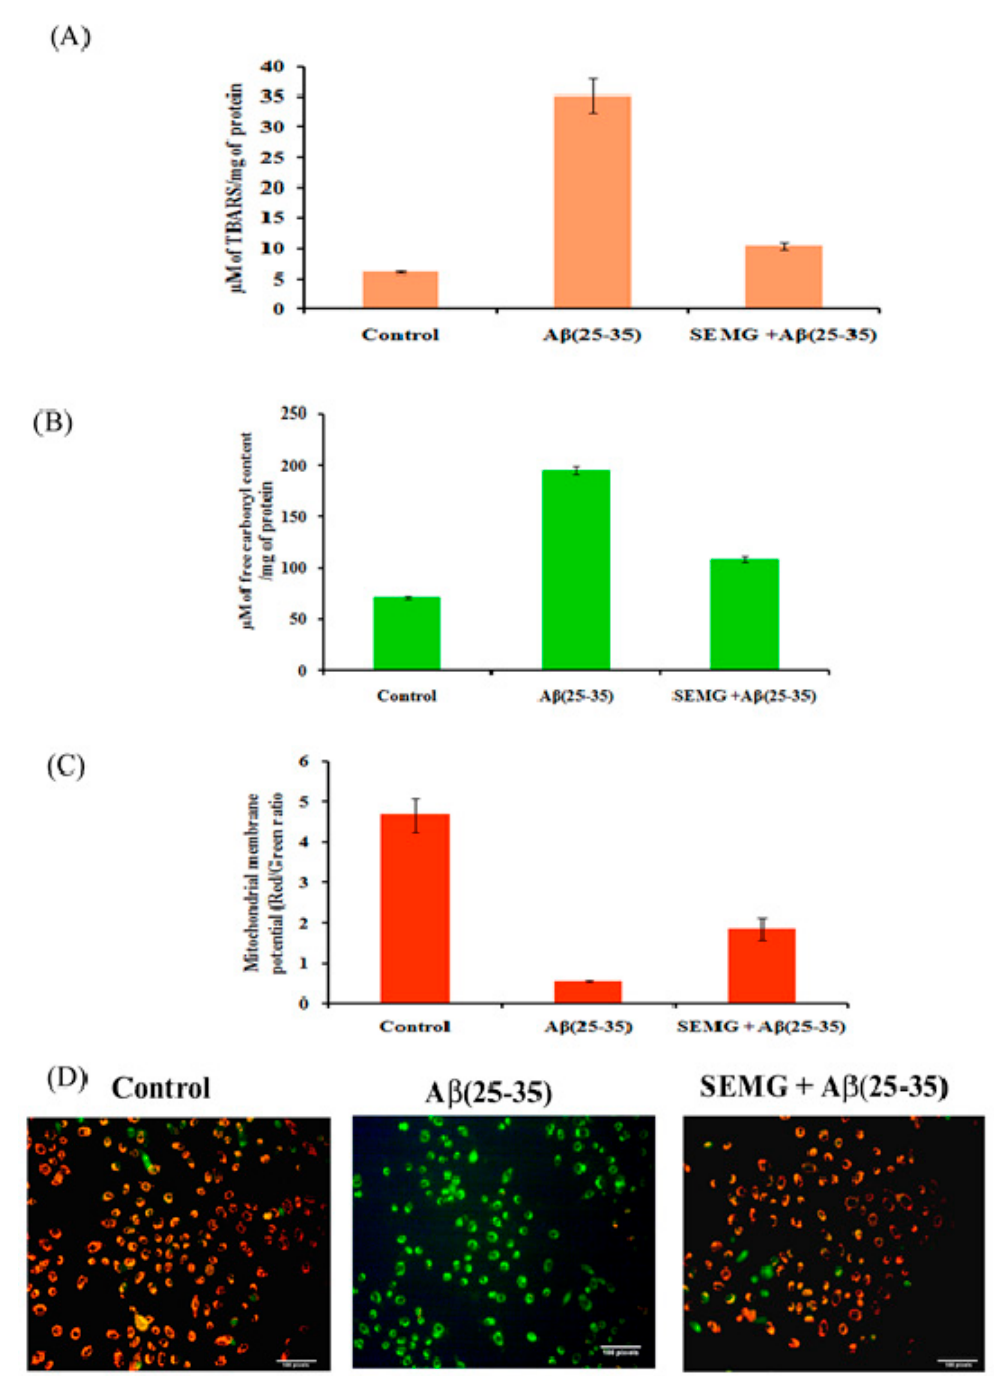
Figure 8. Effect of SEMG on A β (25–35) induced ( A ) lipid peroxiation; ( B ) protein oxidation in Neuro2A cells; ( C ) Bar diagram illustrating the restoration of MMP loss in cells treated with SEMGF; ( D ) Fluorescent microscopic analysis representing the prevention of loss of MMP by SEMG treated groups using JC-1 staining with 20 × magnification. SEMG Impedes Apoptosis in Neuro2A Cells Induced by A β Toxicity Loss of MMP due to A β toxicity leads to activation of the apoptotic pathway, lead- ing to neuronal death. In the present study, the anti-apoptotic effect of SEMG against A β -induced toxicity was assessed by the AO/EtBr dual-staining technique, widely used to identify morphological changes associated with apoptosis. Results showed the pres-